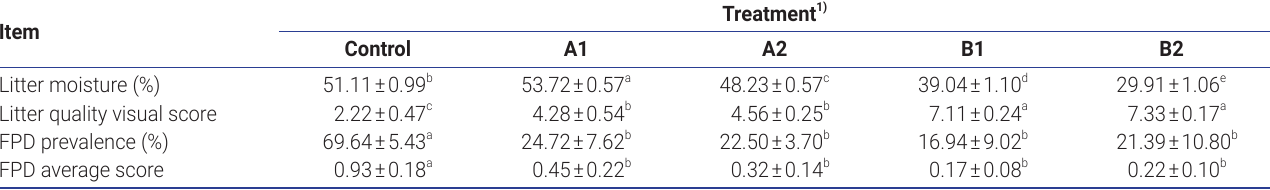
Table 5. Effects of dietary metallo-protease and Bacillus velezensis CE 100 on litter moisture and footpad dermatitis in broiler chickens